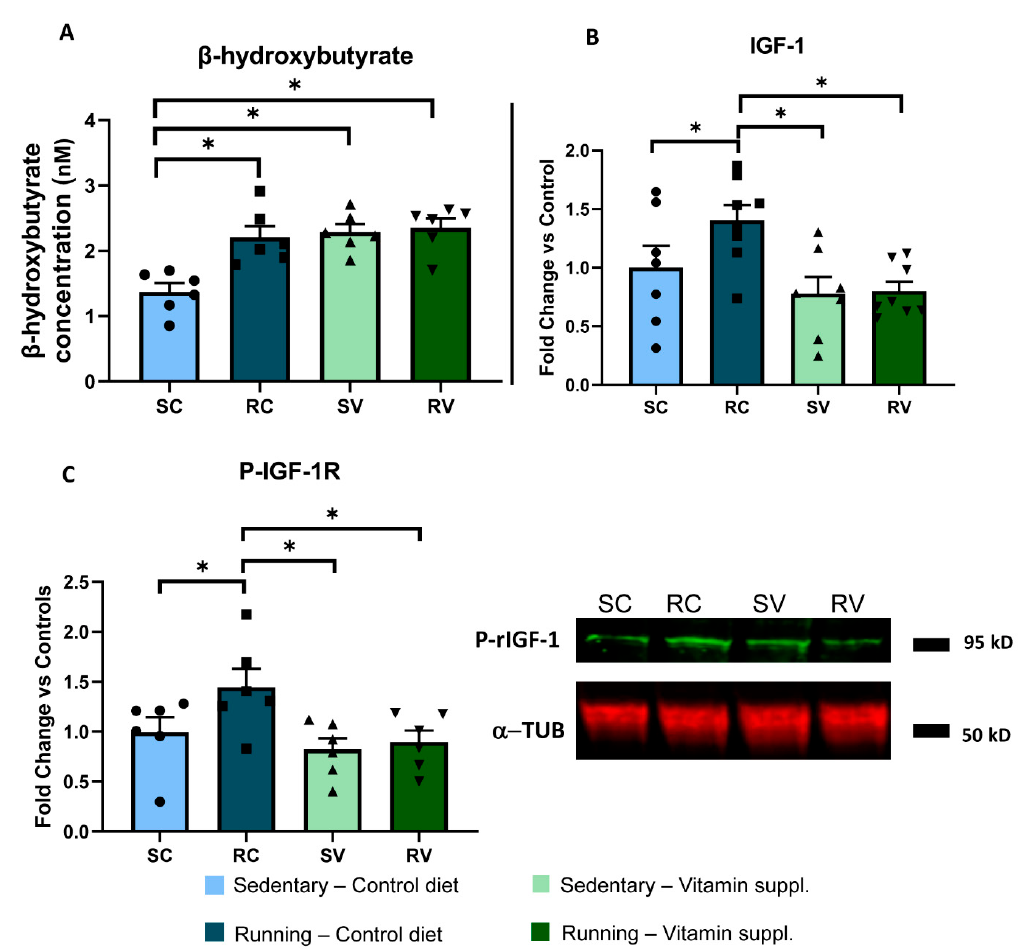
Figure 3. Vitamin supplementation blocks IGF1 increase in running animals. ( A ) Colorimetric assay for serum β -hydroxybutyrate. Running induced an increase in circulating β -hydroxybutyrate with respect to the sedentary condition (RC, n = 6; 2.20 ± 0.17 nM; vs. SC, n = 6; 1.37 ± 0.13 nM; two-way ANOVA, F = 7.17, Holm–Sidak method, p < 0.001). Vitamin supplementation caused an increase of β -hydroxybutyrate levels in sedentary animals (SV, n = 6; 2.29 ± 0.12 nM; p < 0.001), but no further increase was observed after free running. ( B ) ELISA for serum IGF-1. Serum IGF-1 levels were markedly increased in exercised rats as compared to sedentary animals fed with the control diet (n = 8 and n = 7, respectively; two-way ANOVA, F = 1.92, Holm–Sidak method, p = 0.047). Vitamin supplementation completely abolished the IGF-1 increase induced by physical exercise, without any effect in sedentary animals (n = 8 and n = 7, p = 0.003 and p = 0.006, respectively). ( C ) Western blot for pIGF-1 receptor in the visual cortex. Physical activity led to a marked increase of phosphorylated rIG1-1 in the visual cortex of RC (n = 6) vs. SC (n = 6) animals; vitamin supplementation completely blocked this increase, with RV rats (n = 6) displaying levels of phosphorylated IGF-1 significantly lower than those displayed by RC rats (two-way ANOVA, F = 1.74, Holm–Sidak method, p = 0.037, p = 0.013, respectively). No effect was found in the visual cortex of sedentary animals fed with the diet supplemented with antioxidants (n = 6) (SC vs. SV, p = 0.407). The right panel shows representative bands for all groups. To calculate the fold change for both B) and C panels, each individual value was normalized, dividing it by the mean value of the SC control group. * indicates statistically significant differences; error bars represent SEM.